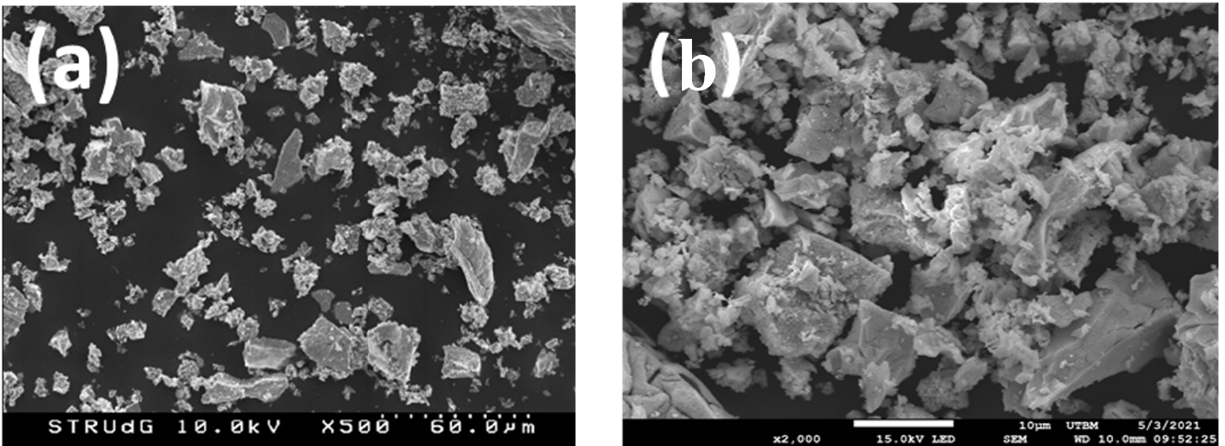
Figure 5. Field Emission Scanning Electron Micrographs of LaCrO 3 before and after hydrogenation ( a , b ) respectively.